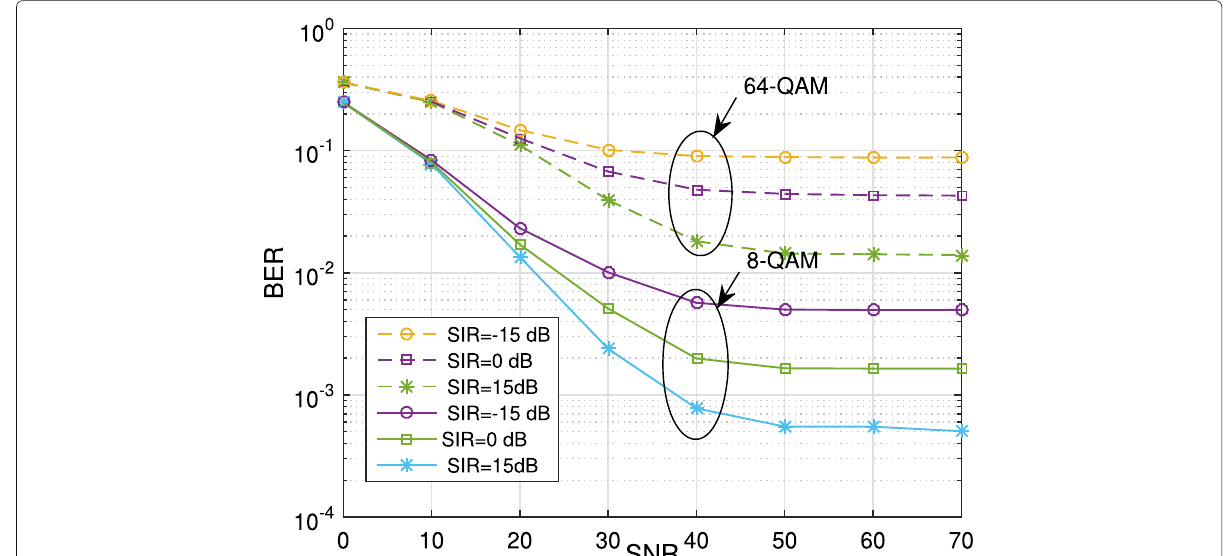
Fig. 6 BER performance of the proposed system for a 2 × 2 MIMO FD system with different QAM